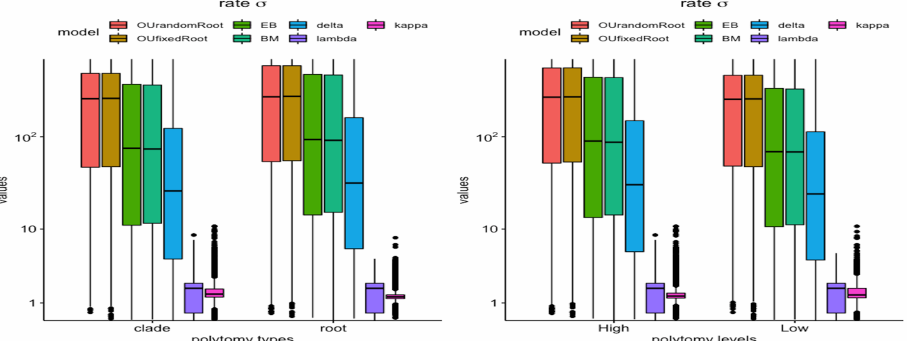
Figure 17. σ 2 estimation concerning different models and polytomy types. Left panel : polynomial type vs. models. Right panel : polynomial level vs.